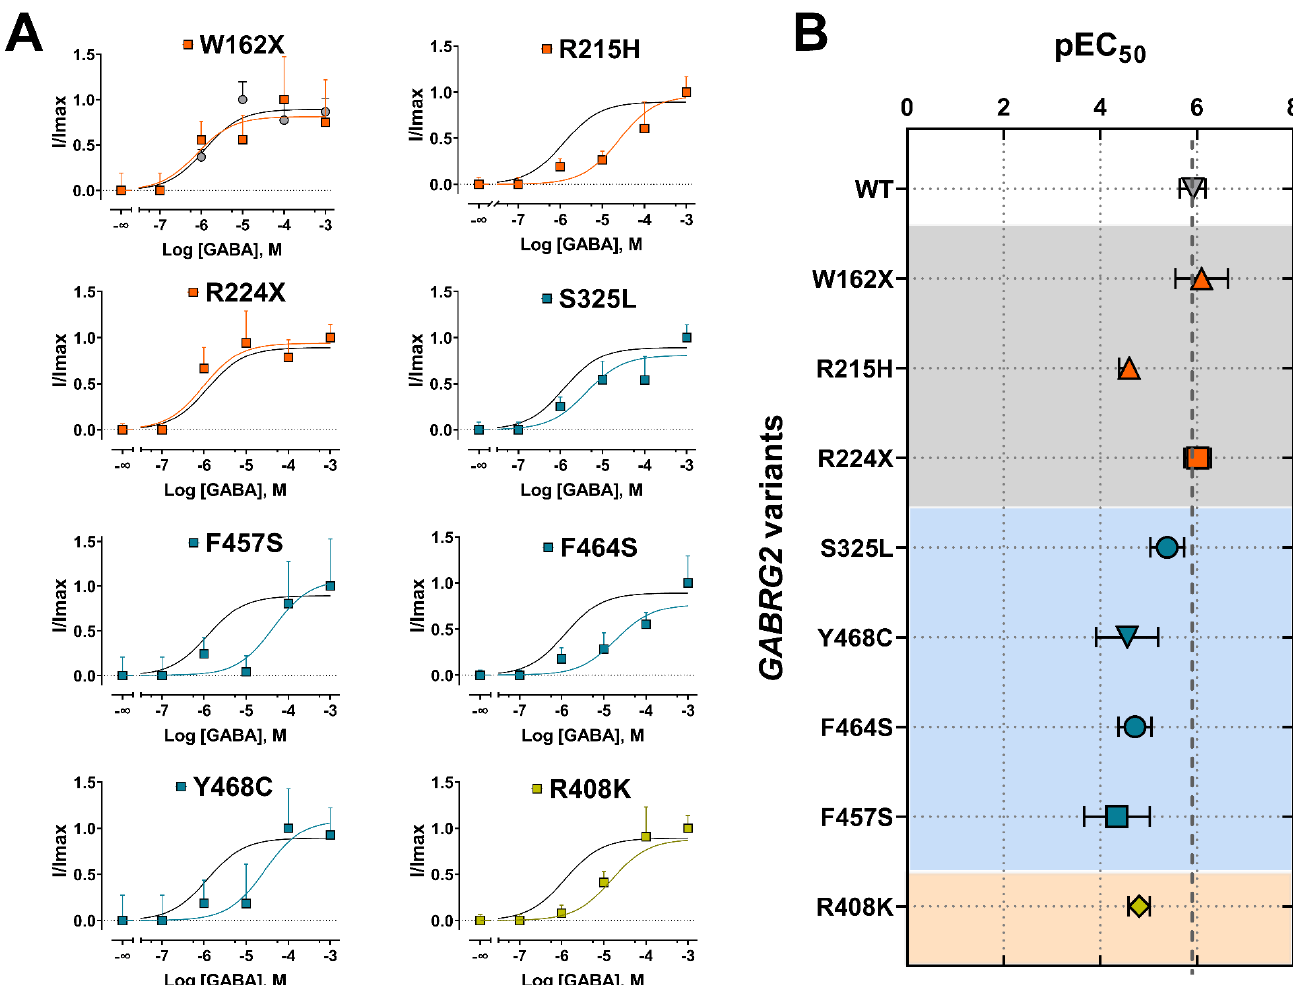
Figure 5. Mutant γ2 subunits altered the potency of GABA A receptors. ( A ) Activation concentration – response curves of GABA A (α1β3γ2) receptors expressed in HEK293T cells on the SyncroPatch 384PE by GABA. A single concentration of GABA was applied to each well. Currents from each well were normalized to the maximal response within the well in the presence of 1 mM of GABA. The data were fitted using a three-parameters sigmoid model, as described in the “Methods” section . The black line represents the fit for the WT condition. The colored lines represent the fit of each experimental condition that corresponds to the data in panel B. Numerical data are reported as mean ± S.E.M. Data points represent the number of successfully patched wells per experimental condition from three independent experiments. ( B ) pEC 50 (negative Log of the EC 50 ) values between WT and mutant γ2 subunits are plotted as the relative change in potency caused by the mutation. Numerical data are reported as mean ± S.D. A summary of the data is shown in Table 4.